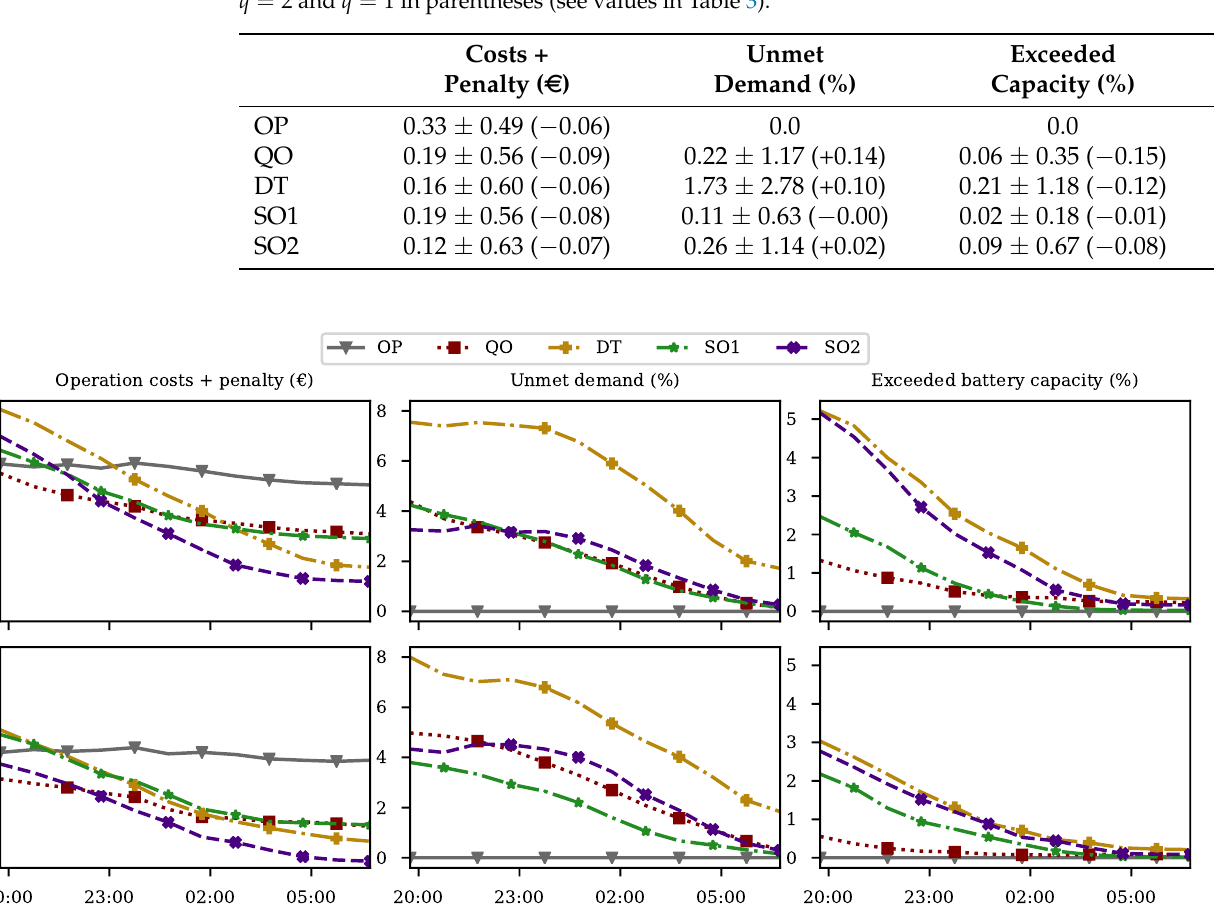
Figure 5. Results for the controlled increasing forecast quality case. Forecast quality was regulated by selecting the best 25 scenarios out of 25 q generated scenarios. Over time, the forecast quality increased. The figure shows the total end results per time step as if the decisions after this time step were not changed. In the case study, new decisions were made every 15 minutes. In the graph, the results are averages for each hour to increase